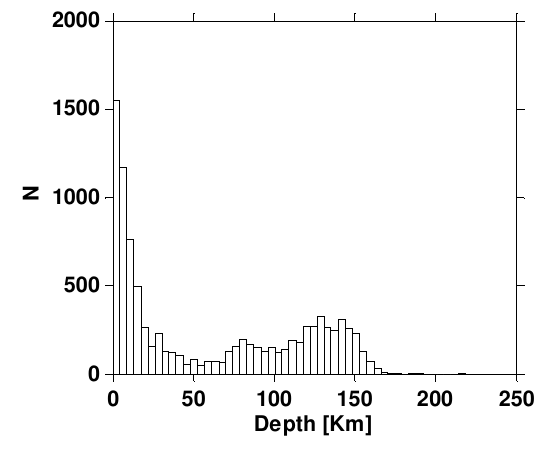
Fig. 1. Map of the seismicity of Vrancea from 1978 to 2008. 302 Fig. 2. Depth distribution of seismicity of Vrancea. 303 Fig. 3. Hour-depth distribution of Vrancea earthquakes. 304 Fig. 4. Hour-magnitude distribution of Vrancea earthquakes. 305 Fig. 5. Frequency-magnitude diustribution of (a) crustal and (b) 306